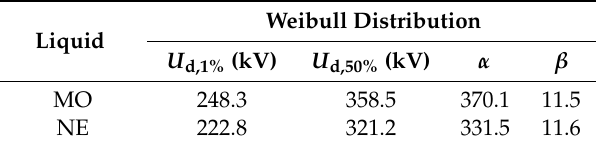
Table 3. Breakdown results for conductor test at positive polarity, Weibull distribution fitting.